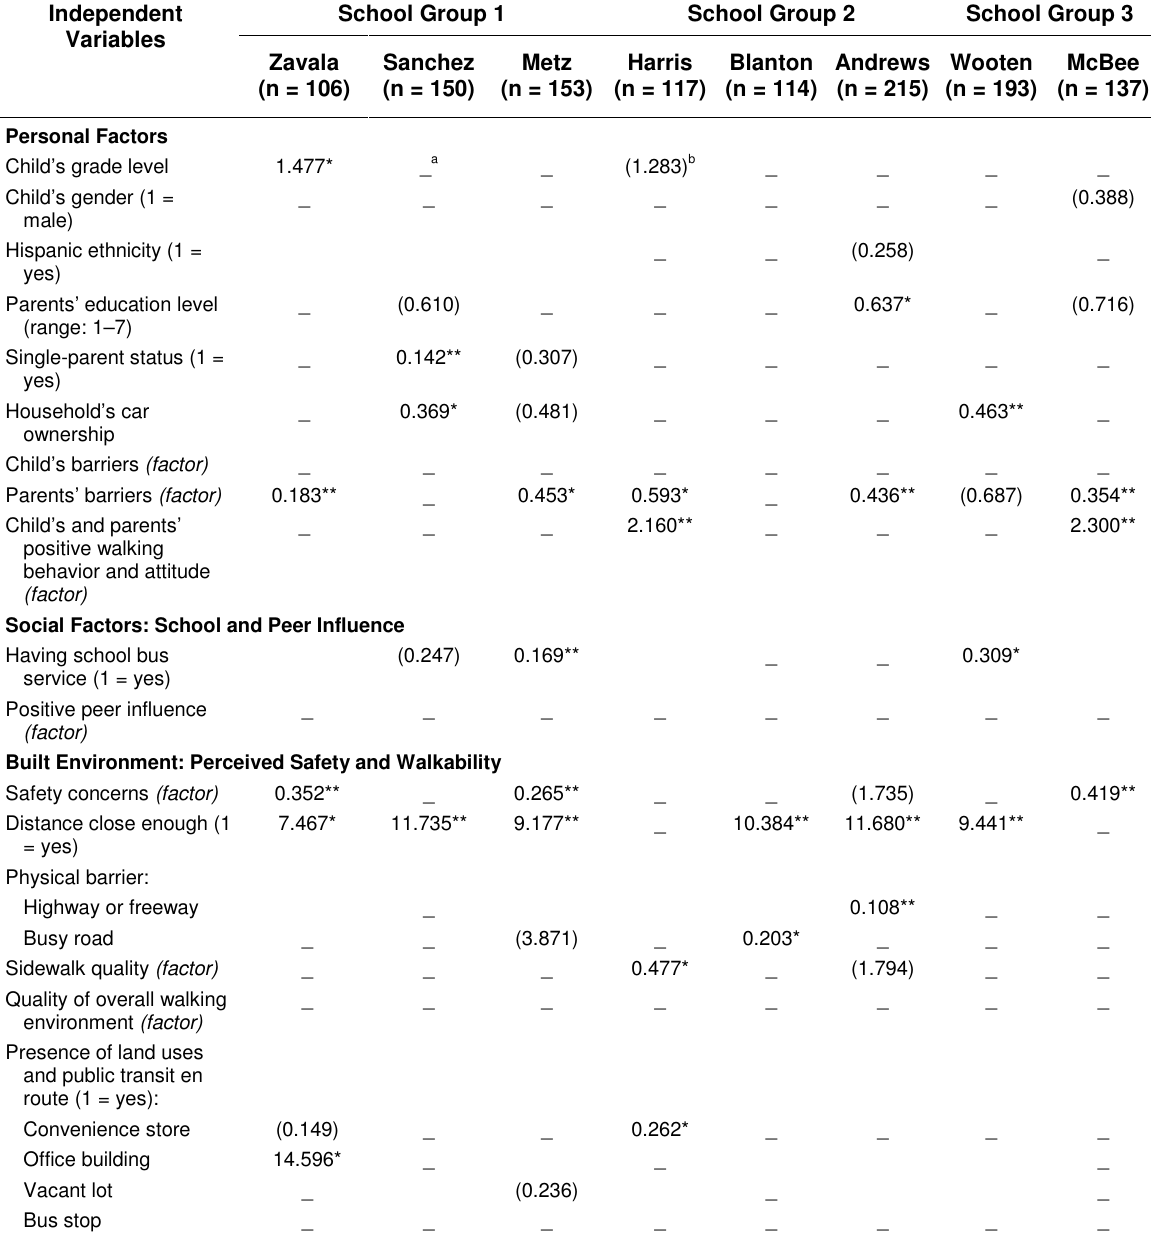
Significant Odds Ratios from Individual Binary Logistic Regression Models for Each